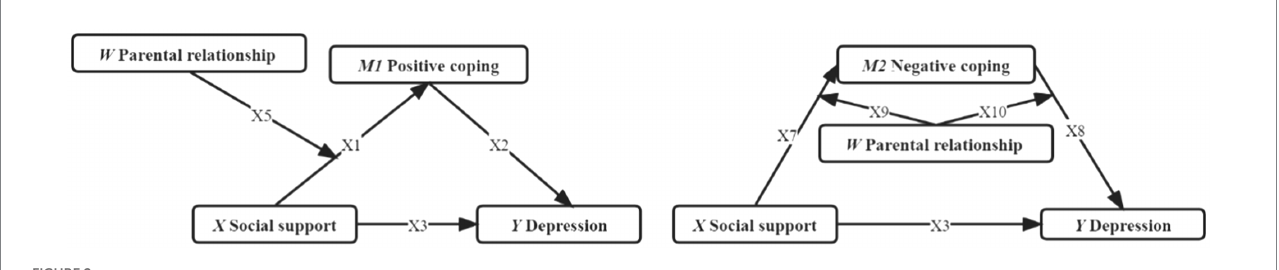
FIGURE 2 Significant pathways of the parent–child relationship in the moderated model.